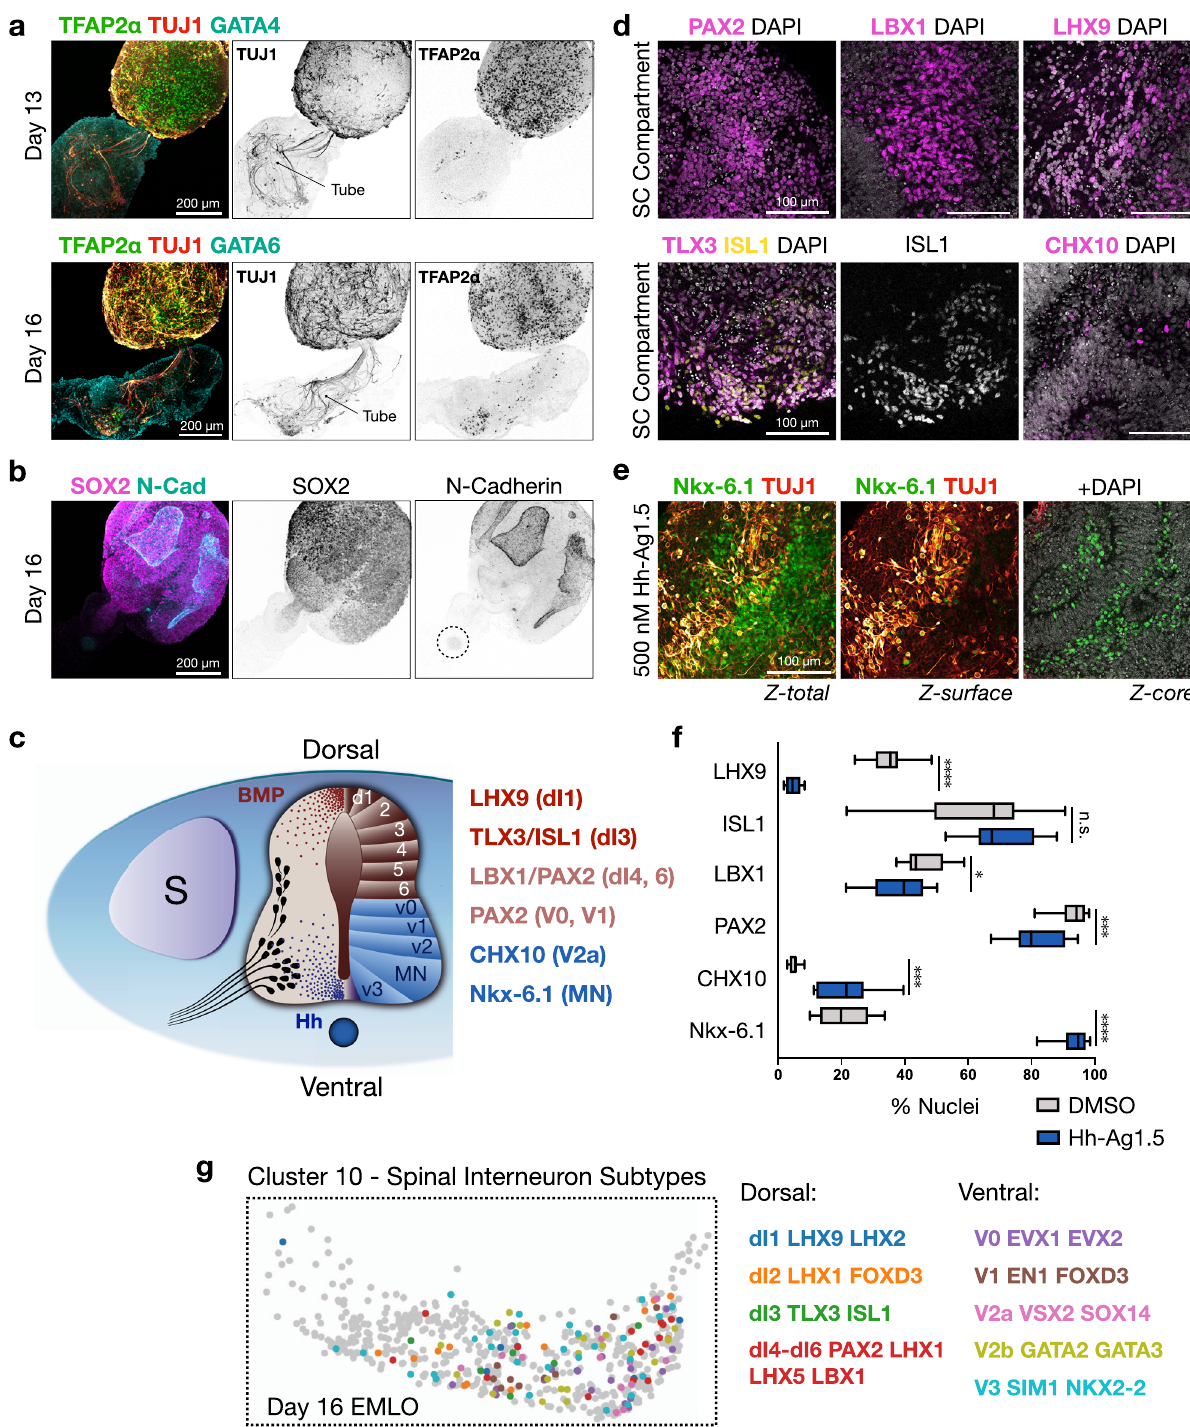
TUJ1 fi bers were detected within the lumen. By comparison of maximally projected Z-stacks to individual Z-slices in EMLOs at day 22, we demonstrated the retained envelopment of the gut tube and the primary large peripheral ganglion, in addition to the establishment of smaller satellite ganglia distributed throughout the ME in support of advancing neural pattern complexity (Fig. 5e). By 3D reconstruction of the EMLO exterior, an undu- lating GATA4 + ME surface interpenetrated by neuronal fi bers and ganglia was evident. We refer to the anterior pole of the gut tube as the anterior intestinal portal-like region, or